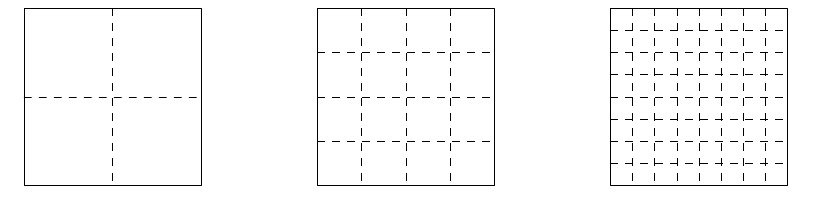
Figure 15: Partitions of the square [ 0 , 1 ) 2 into dyadic squares of orders 2, 3 and